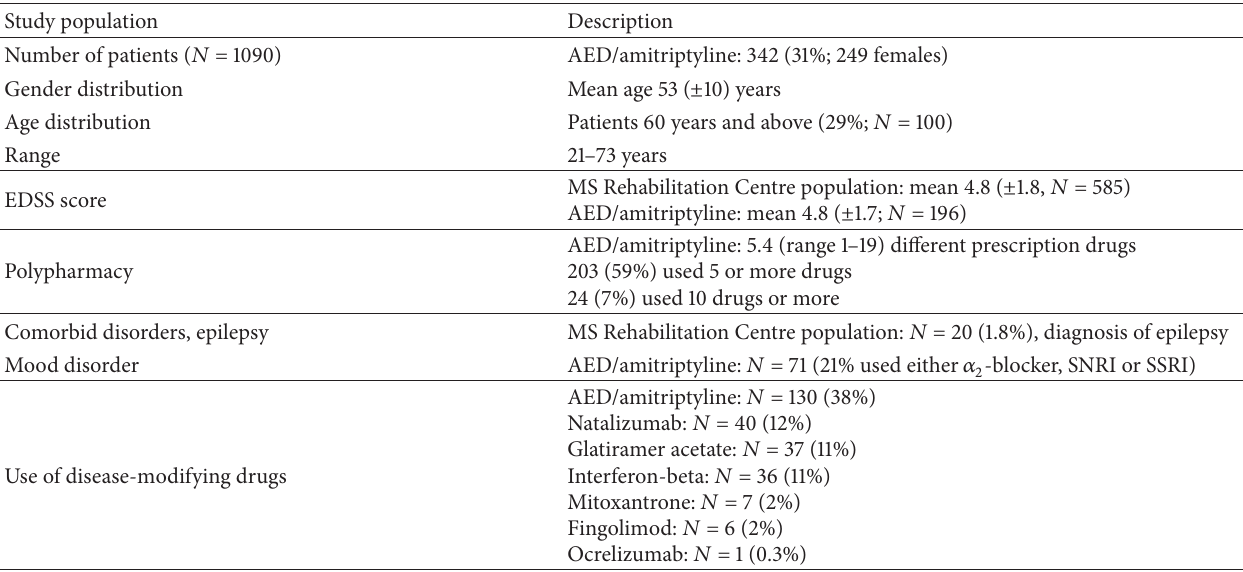
Table 1: Patients’